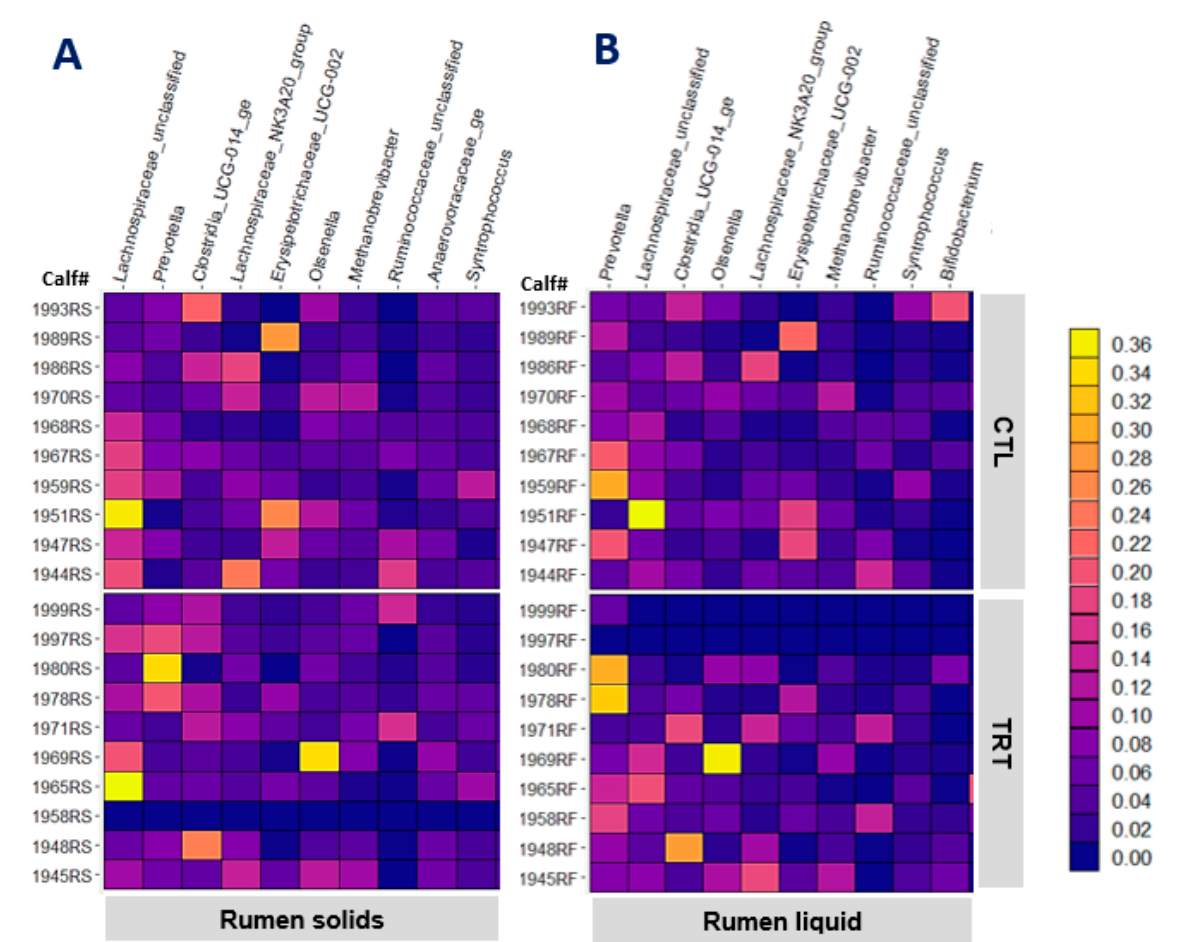
Figure 2. The relative abundance of the 10 most abundant genera in rumen solids ( A ) and rumen liquid ( B ) of weaned calves (95 d old) in control (CTL) and MCE-fed (TRT) groups.